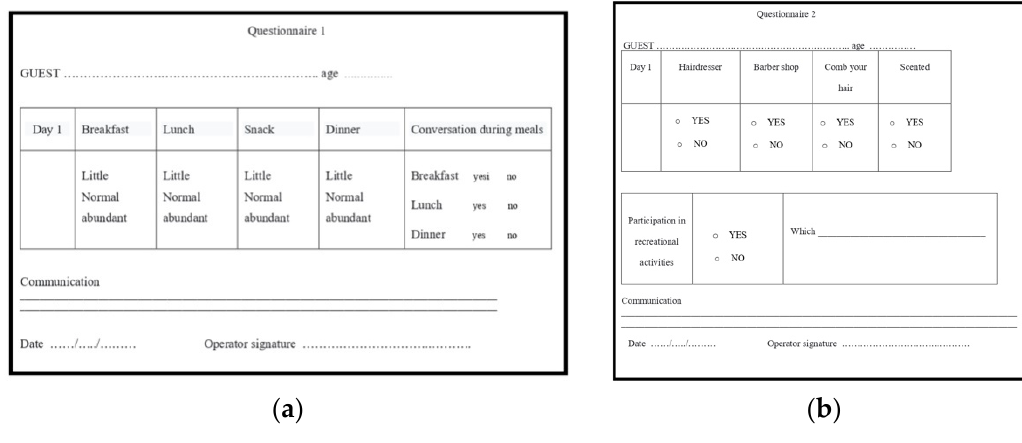
Figure 2. ( a ) Dossier 1; ( b ) Dossier 2.